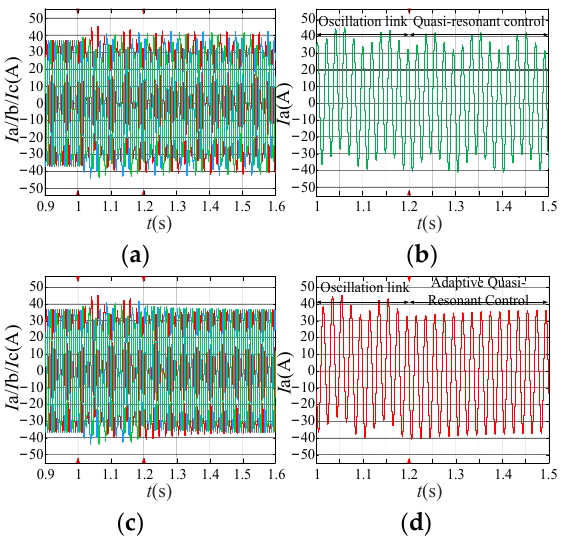
Figure 11. Comparison of inhibition effects between two resonant controllers with SSO frequency of 10 Hz: ( a ) quasi-resonant controller; ( b ) stator current single phase magnification; ( c ) adaptive quasi-resonant controller; ( d ) stator current single phase magnification.